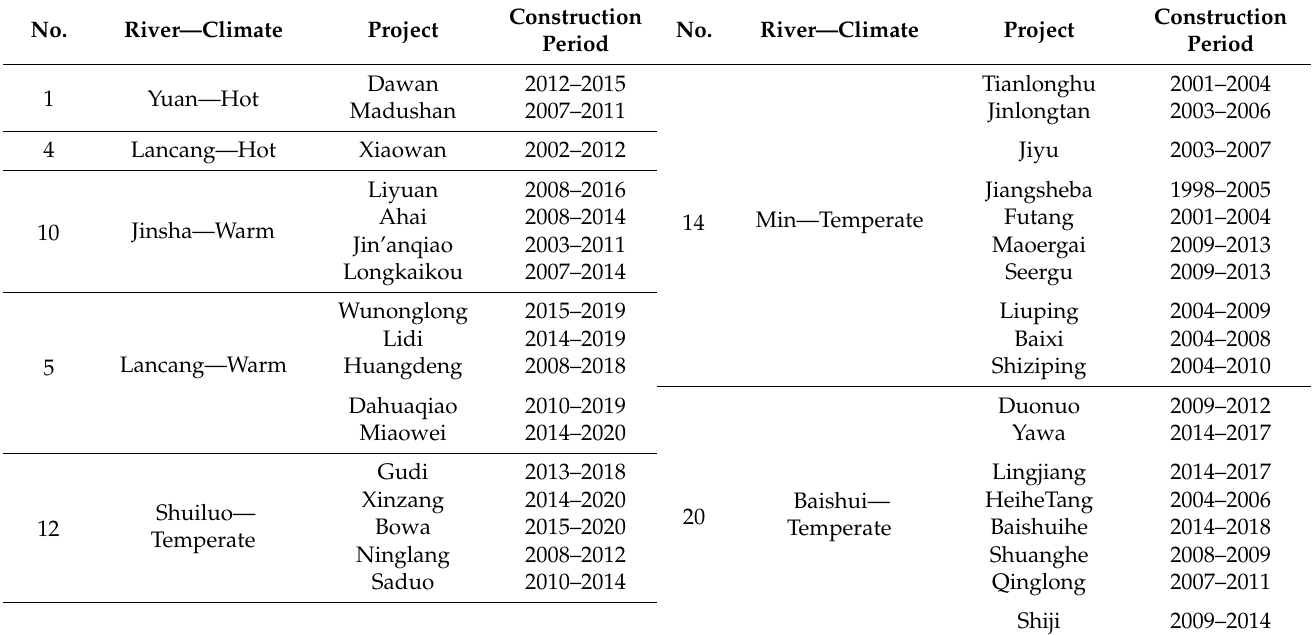
Table 6. Information regarding hydro-power projects in dry valleys of Southwest